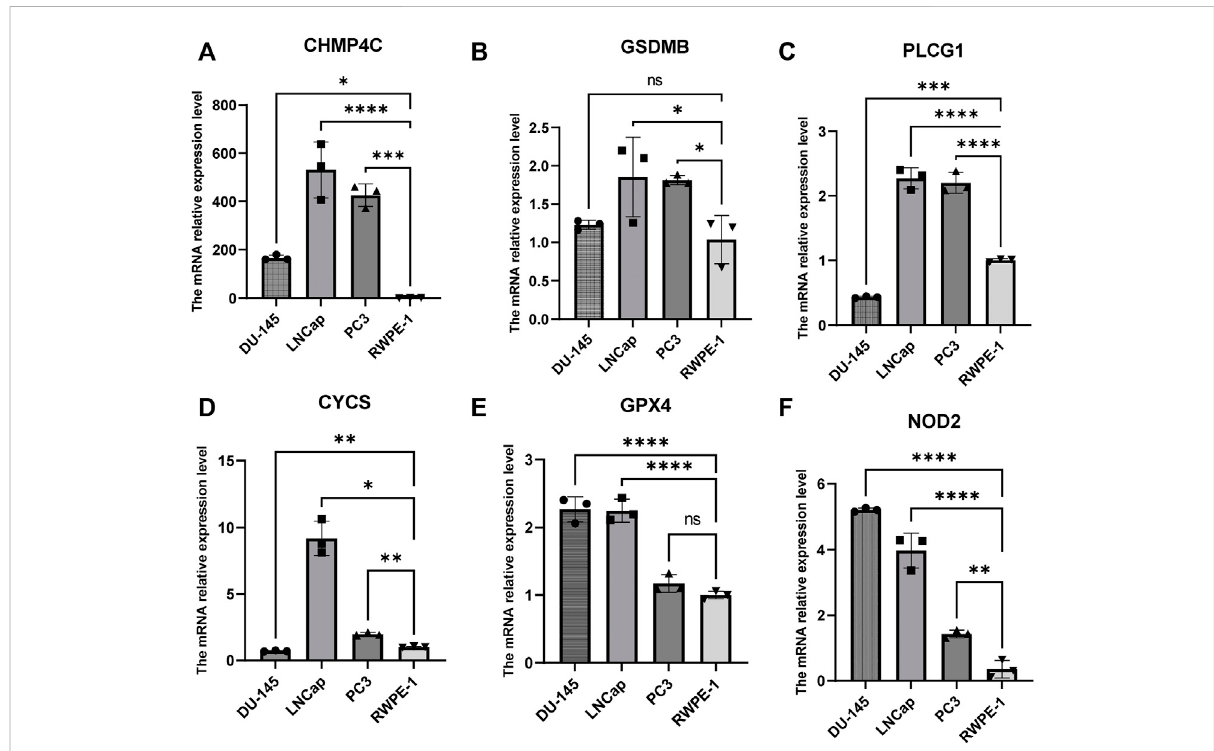
FIGURE 3 The mRNA expression levels of 6 hub genes in PCa cells (DU-145, LNCap, PC3) and the normal prostate epithelial cell line (RWPE-1). (A – F) The mRNA relative expression levels of CHMP4C, GSDMB, PLCG1, CYCS, GPX4, and NOD2 in DU145, LNCap, PC3, and RWPE